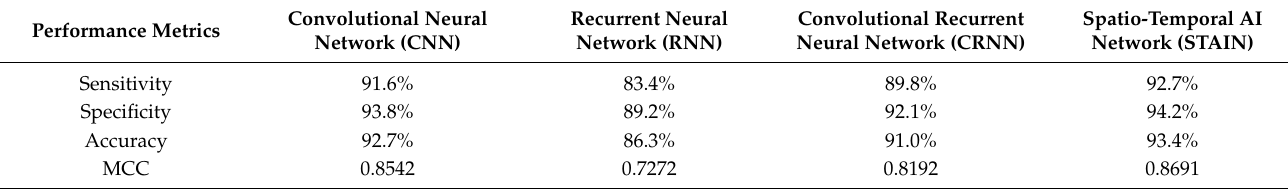
Table 3. Summary of results of the comparative study of CNN, RNN, CRNN, and the proposed STAIN machine learning models for cough detection. The sensitivity, specificity, accuracy, and Matthews Correlation Coefficient metrics were obtained for all four models using the same datasets. As can be seen, the STAIN model outperforms all the other traditional AI models with its deeply meshed spatio-temporal feature extraction architecture, which is more advantageous for effectively classifying respiratory